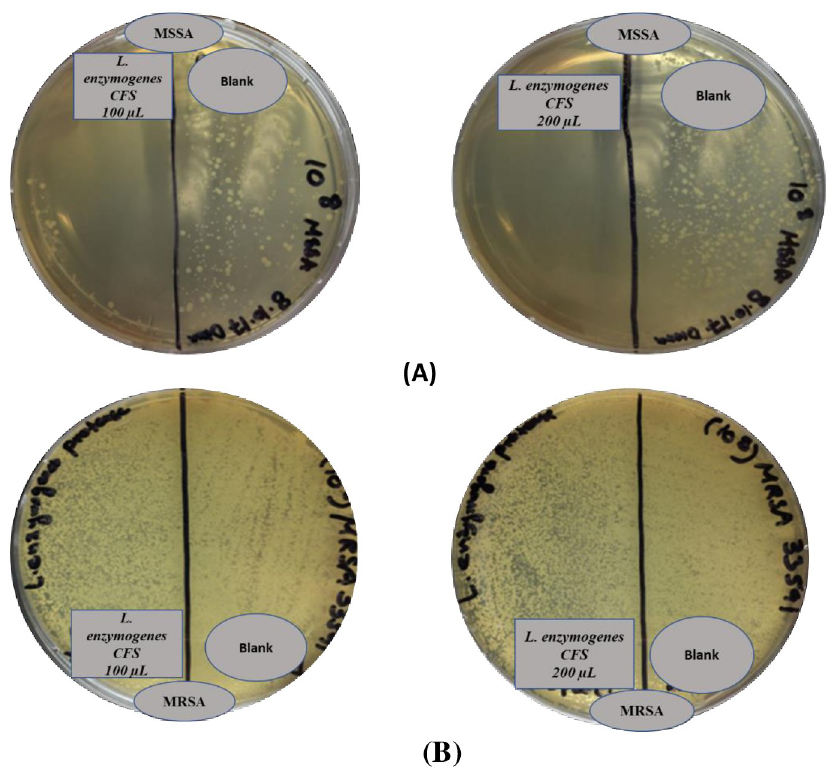
Fig 2. L . enzymogenes CFS growth inhibitory activity against; (A) MSSA, (B) MRSA using 100 μ L and 200 μ L L . enzymogenes CFS